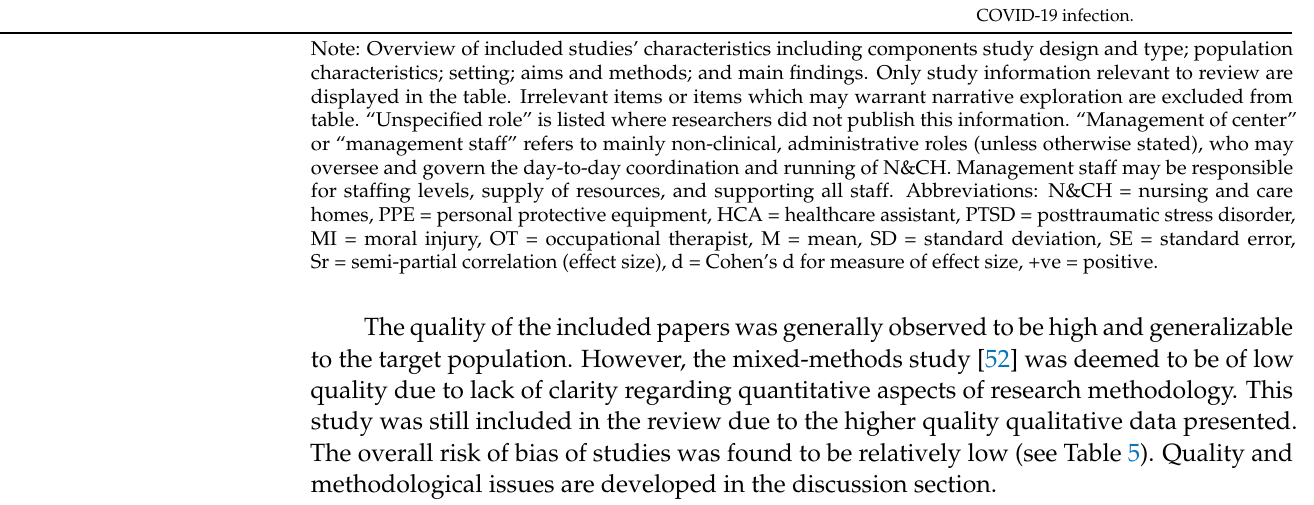
Table 5. Critical appraisal of included